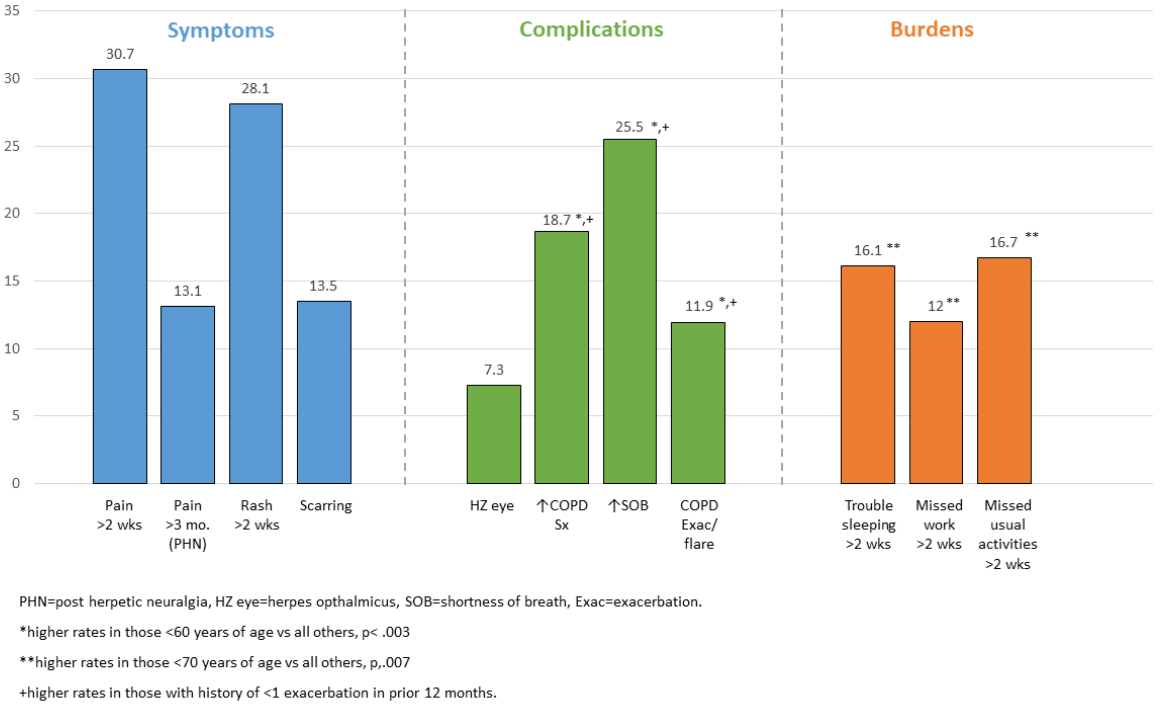
Figure 2. Long term HZ symptoms, complications, and burden experienced by participants who previously had HZ. (% of n = 192). Table 2. Participants’ perceived impact of symptoms and problems of HZ, and the importance of preventing them, for people with